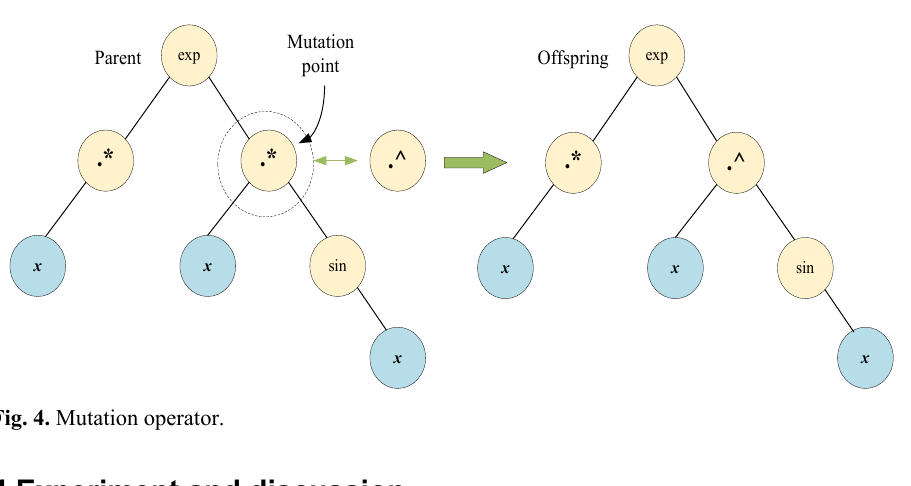
Fig. 4. Mutation operator.